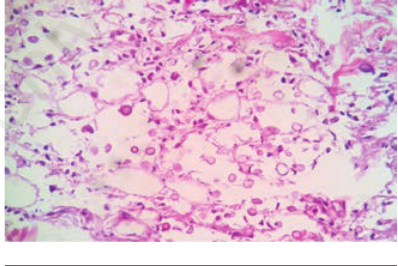
Figure 1. Biopsy of the subcutaneous tis- sue in Hematoxylin & Eosin (40× magnifi- cation). Fungal spores without inflamma- tory